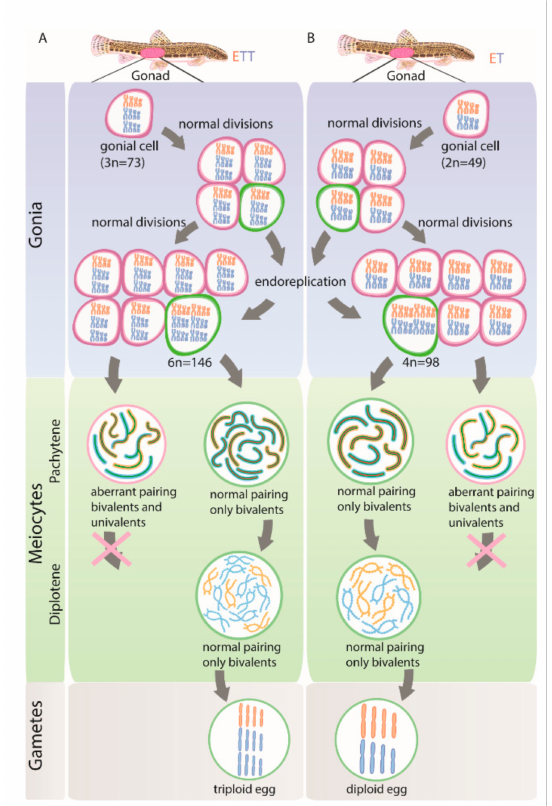
Figure 6. Schematic overview of gametogenic pathway during clonal gametogenesis in triploid ETT ( A ) and diploid ET ( B ) hybrids. Each column shows individuals, gametogenic pathways with the indication of the germ cells, cells in two meiotic stages (pachytene and diplotene) and gametes. E (orange chromosomes), T (blue chromosomes) indicates genomes of both parental species C. elongatoides and C. taenia correspondingly. Cells with premeiotic genome duplication (green outlines) emerged in individual gonocytes before meiosis. After entering meiosis such cells form 73 bivalents ( A ) or 49 bivalents ( B ) during pachytene and diplotene followed by the formation of triploid ( A ) and diploid ( B ) gametes. Gonocytes with non-duplicated genome (pink outlines) enter meiosis and form univalents and bivalents during pachytene. Such cells cannot proceed beyond